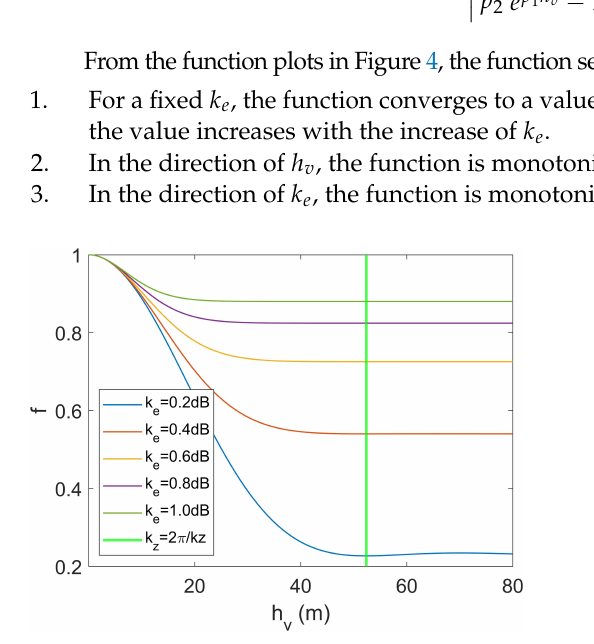
Figure 4. The RVoG function with θ = π /4, k z = 0.12 m − 1